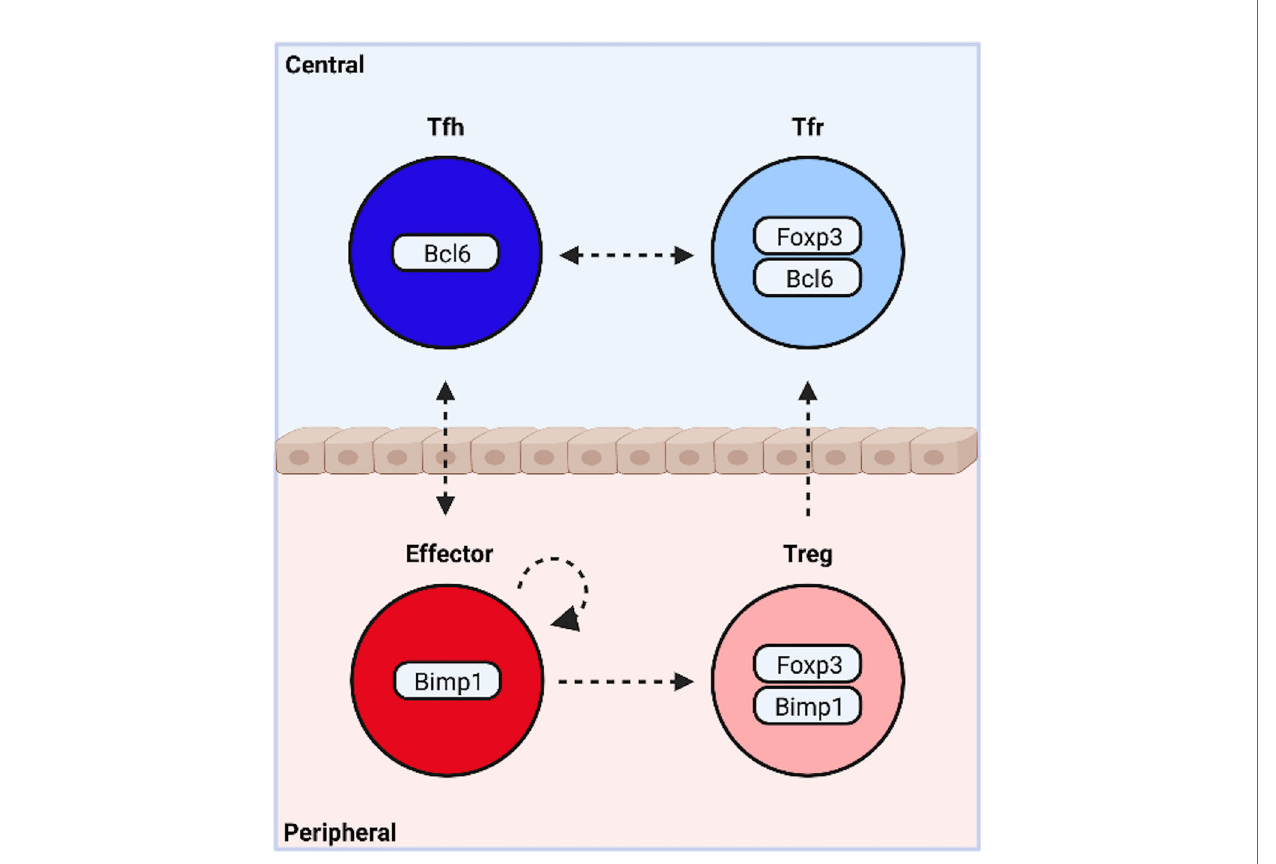
FIGURE 2 | Functional Bifurcations Among CD4 + T Cells. Following activation, naïve cells are programmed to modulate central or peripheral processes. Similarly, activated cells either drive or suppress in fl ammation. These functional bifurcations are coincident and suf fi ciently independent to allow for the simultaneous generation of all four potential outcomes. Pro-in fl ammatory T follicular helper (Tfh) cells organize germinal center responses, while traditional non-Tfh effector subsets promote cellular responses at the site of in fl ammation. Both exist in mutual opposition with a suppressive counterpart. T follicular regulatory cells (Tfr) modify central events, while peripherally induced regulatory T cells (pTregs) suppress peripheral in fl ammation. The dynamic heterogeneity of CD4 + T cell responses may be due in part to plasticity between subsets (indicated by arrows). Created with